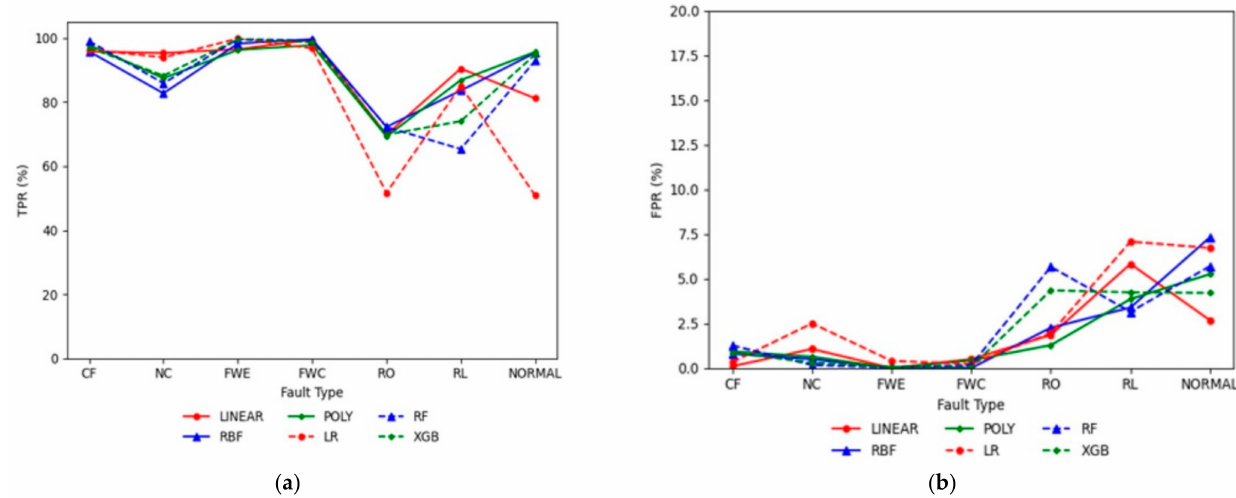
Figure 7. TPR and FPR values for each classification method (Case 1): ( a ) TPR; ( b ) FPR.